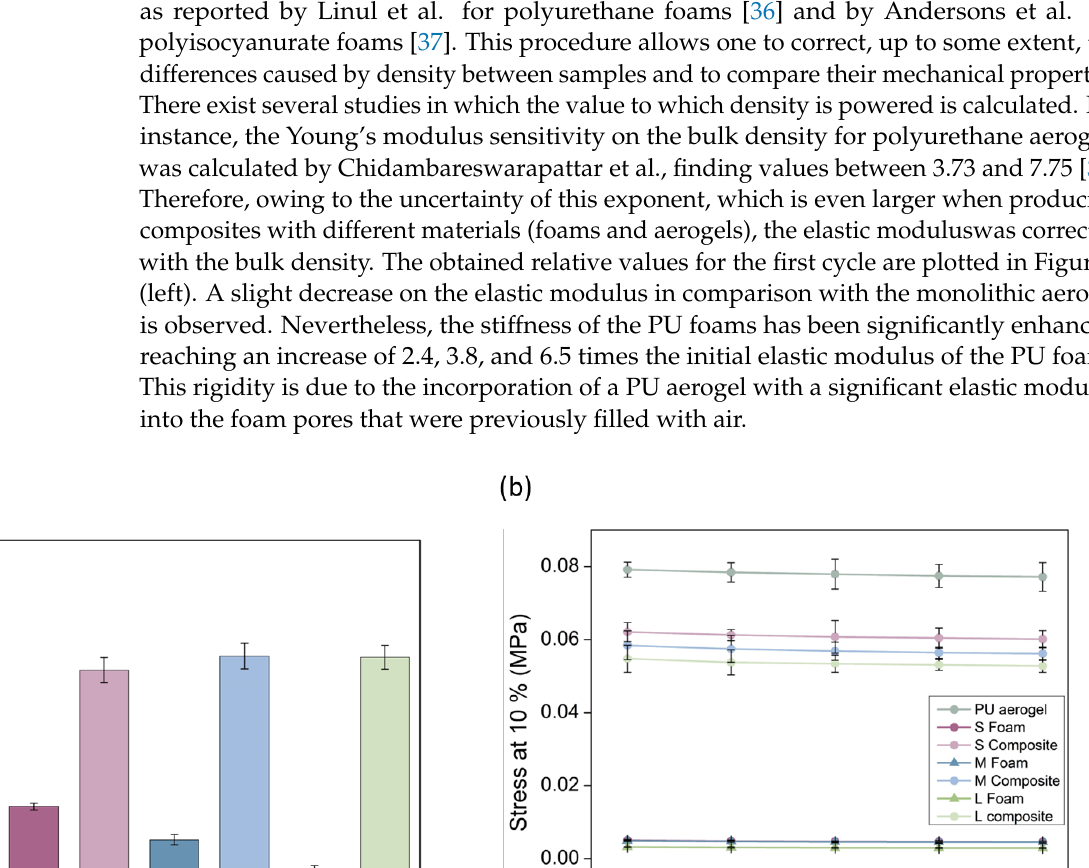
Figure 6. ELC graph the produced samples.